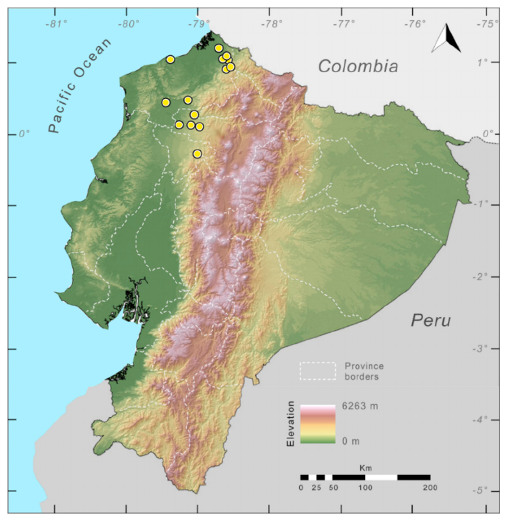
Figure 203. Distribution of Sachatamia ilex in Ecuador (yellow dots).